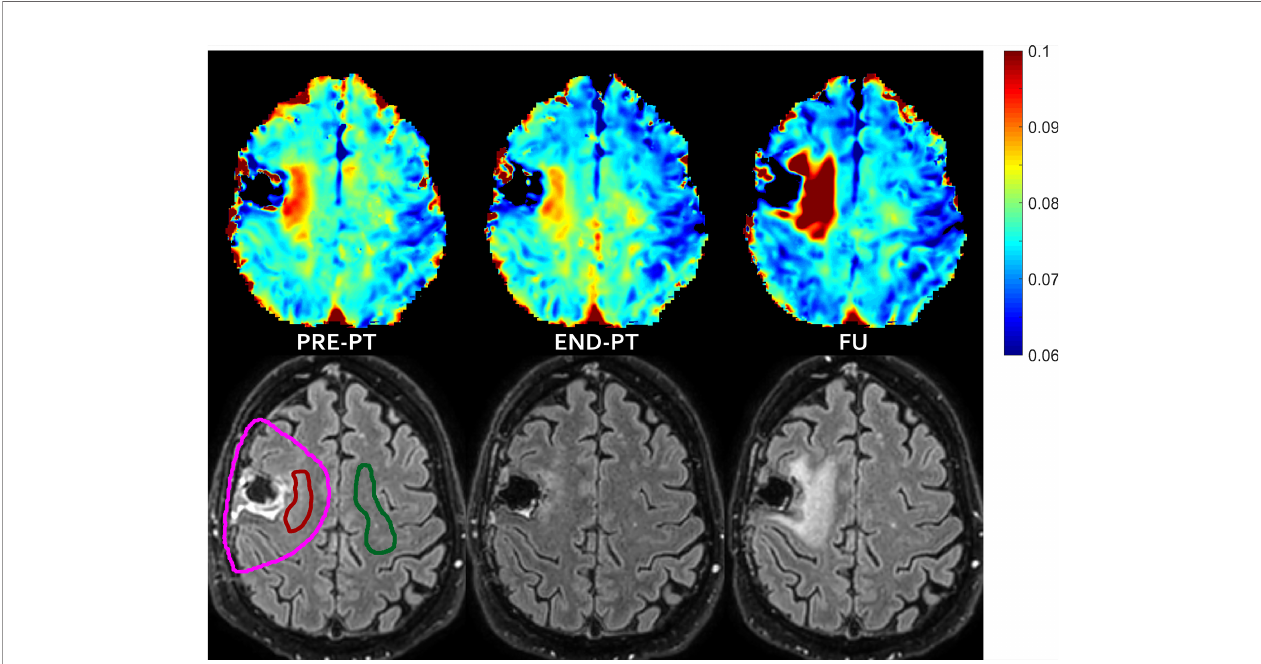
FIGURE 3 | FLAIR increase pattern after temporary T2 decrease — In patient #2 the mismatch, i.e. the abnormal T2 area that extended outside hyper-intense FLAIR area before proton irradiation (left) evolved into new area of FLAIR hyper-intensity diagnosed as radiation induced damage at follow-up (right), with some partial temporary recovery at the end of the radiation treatment (middle). T2 intra/extracellular water maps (top) and FLAIR images (bottom) are shown. Colored bar is shown in seconds. On pre-PT FLAIR image the contours of the CTV (violet line), of the mismatch ROI (red line) and of the contralateral healthy ROI (green line) are